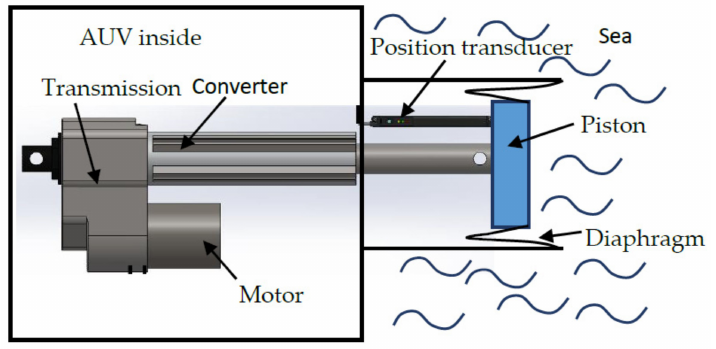
Figure 2. Generic principle of the electromechanical